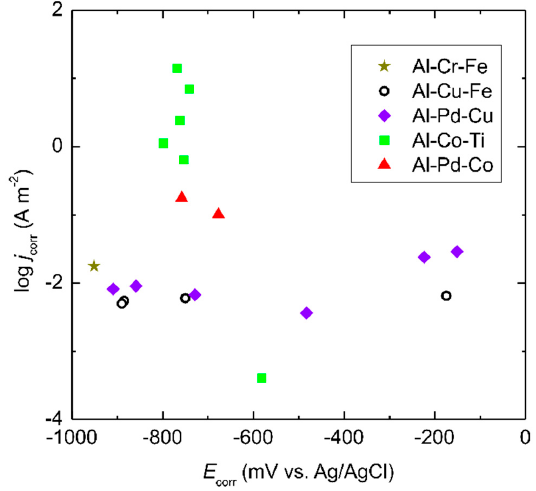
Figure 12. Corrosion current densities versus corrosion potentials of selected ternary Al-based complex metallic alloys (as-cast and as-annealed alloys only). For the color interpretation of this figure, the reader is referred to the web version of this article.